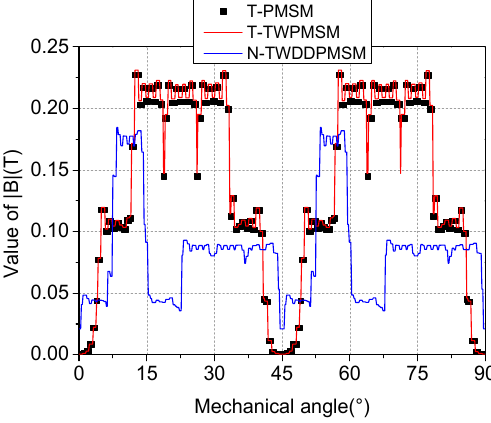
Figure 7. Flux density distribution for armature magnetic field.